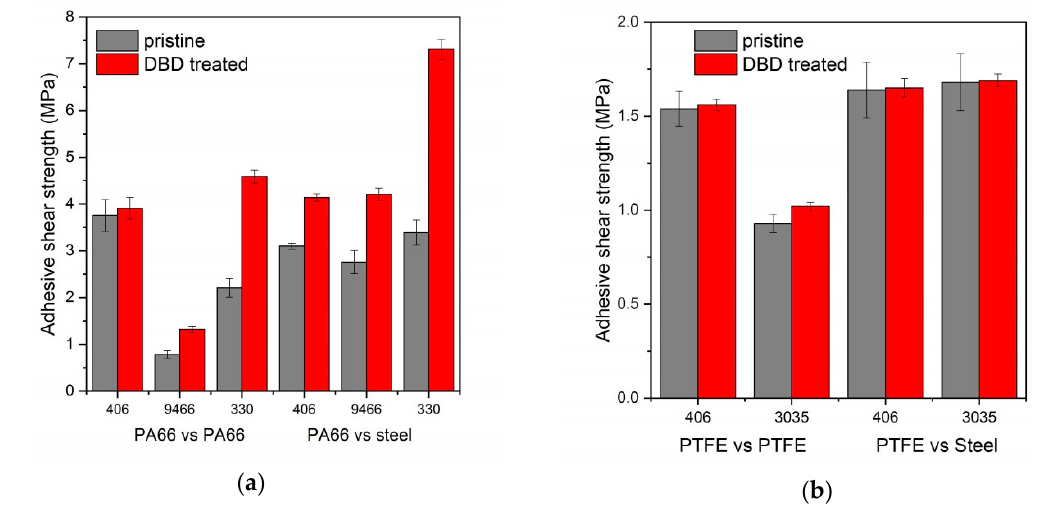
Figure 6. Adhesive shear strength of pristine (grey) and plasma ‐ treated (red) polymer/polymer and polymer/steel joints using various adhesives for PA66 ( a ) and PTFE ( b ).